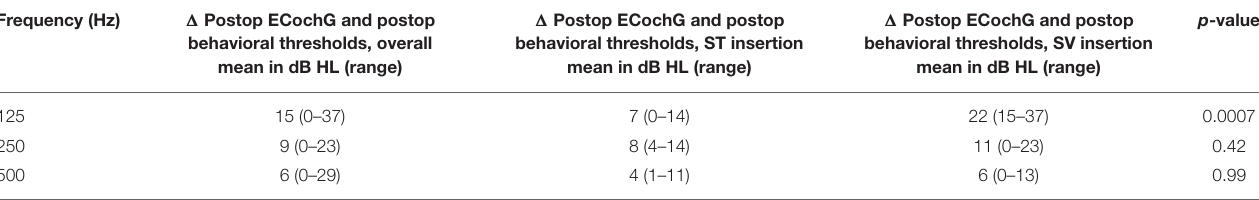
TABLE 3 | The mean absolute difference between postoperative electrocochleography (ECochG) thresholds and postoperative behavioral thresholds at 125, 250, and 500Hz frequencies are shown in the overall cohort. Frequency (Hz)